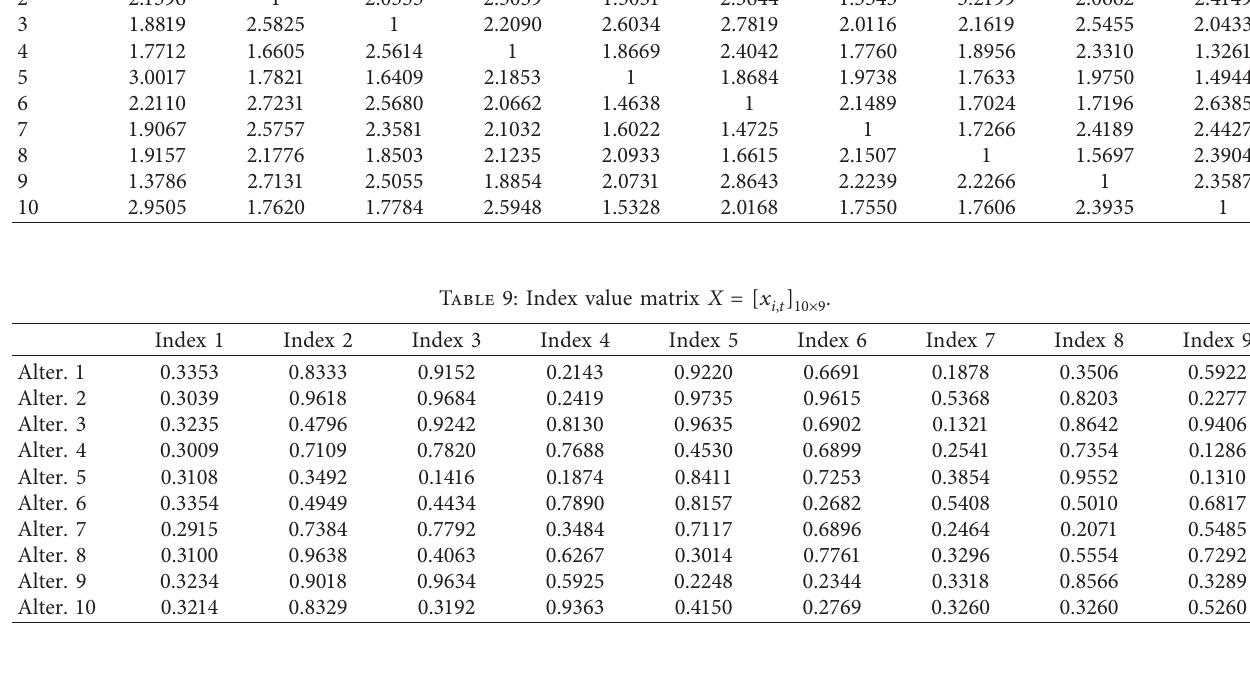
Table 10: Subjective weight.